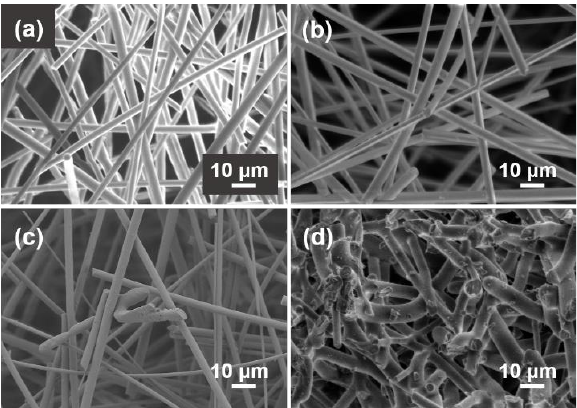
Figure 11. SEM images of SiO 2 fibrous porous materials after heat treatment at different temperatures. ( a ) 600 °C, ( b ) 800 °C, ( c ) 1000 °C and ( d ) 1200 °C. ( a ) 600 ◦ C, ( b ) 800 ◦ C, ( c ) 1000 ◦ C and ( d ) 1200 ◦